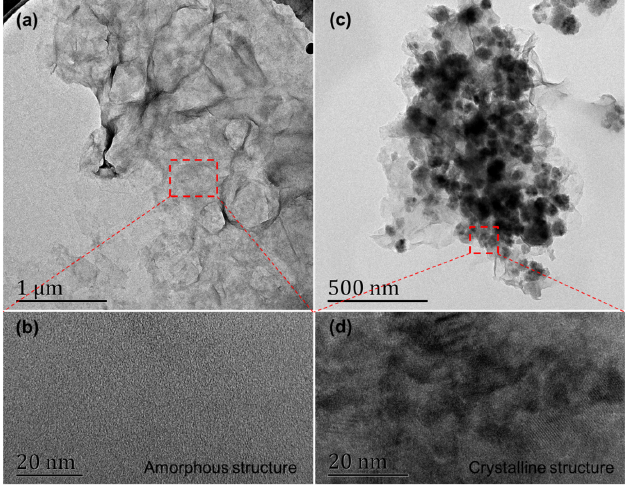
Figure 4. Representative transmission electron microscopy (TEM) and high-resolution transmission electron microscopy (HRTEM) micrographs of GO ( a , b ) and GO@Fe 3 O 4 ( c , d